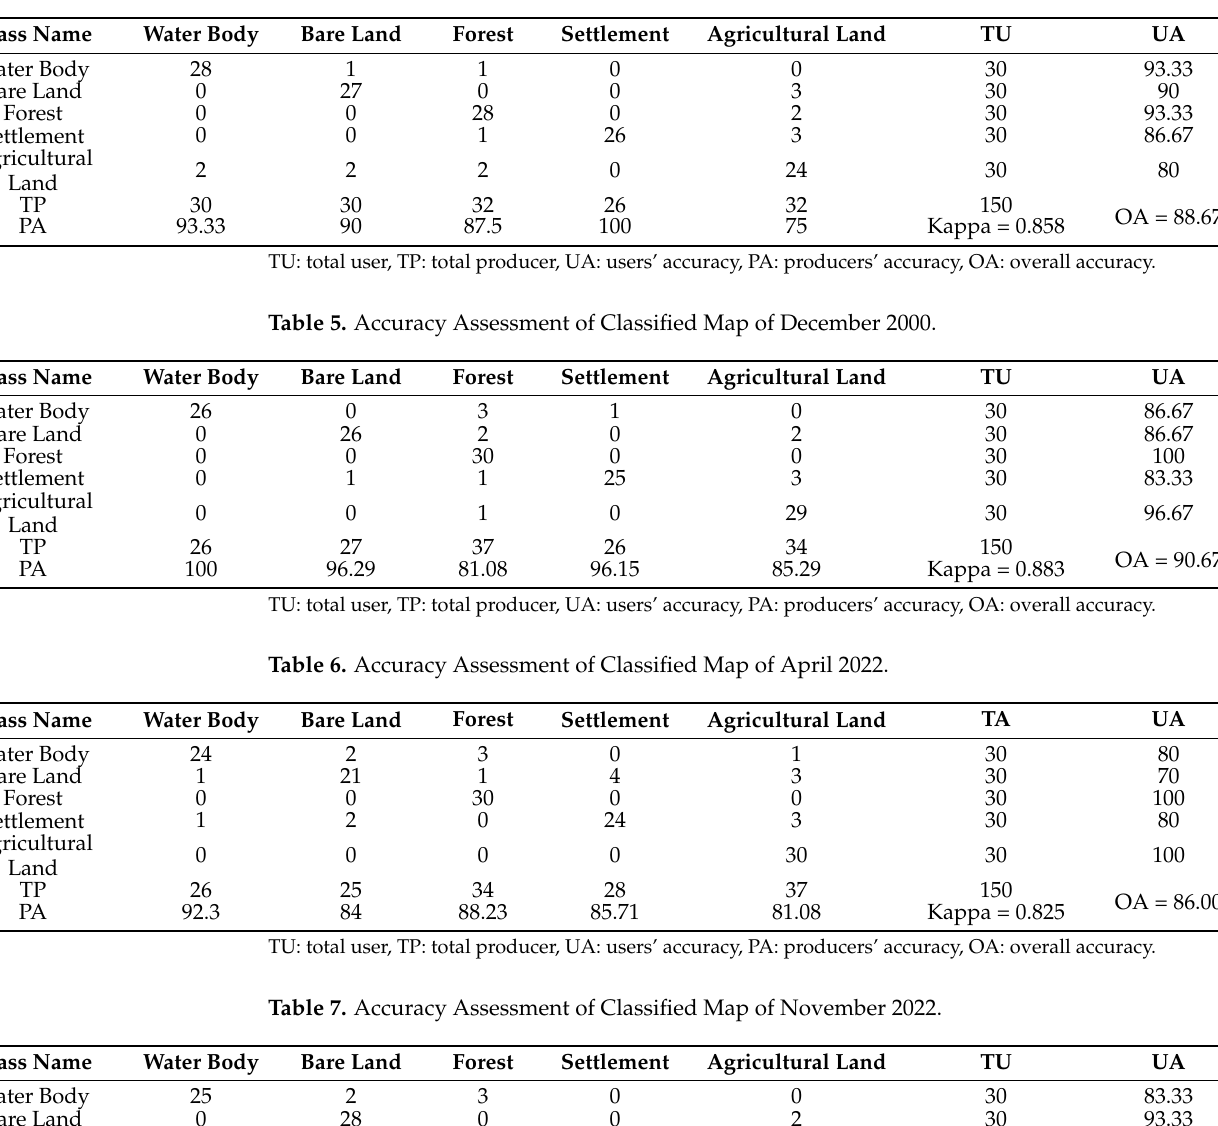
Table 4. Accuracy Assessment of Classified Map of April 2000.